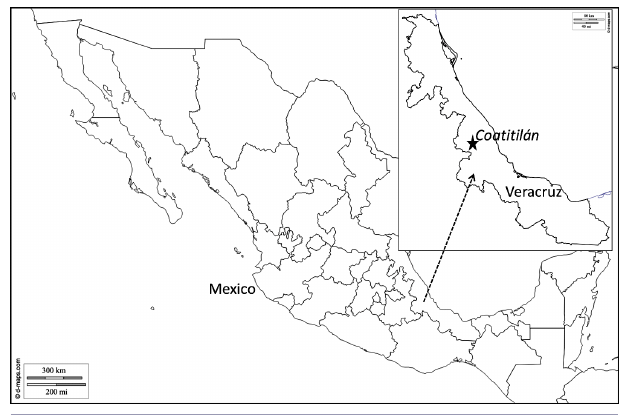
Fig. 2 . Location of Coatitilán in Veracruz, Mexico (© d-maps.